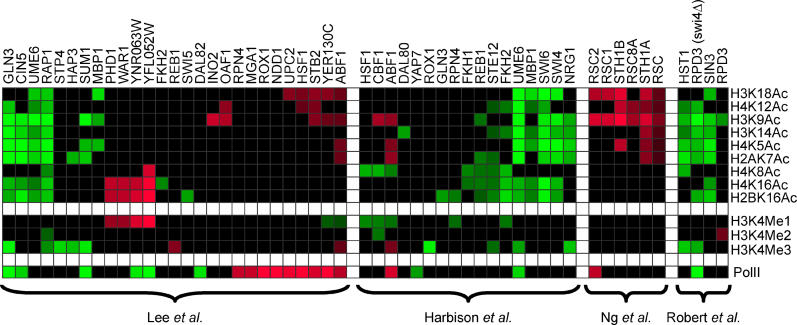
Histone ModifiersAnalysis of differential modification of nucleosomes associated with various transcriptional regulators. Promoter nucleosomes located near binding sites of the indicated factors were tested for enrichment of all modifications relative to the overall promoter modification pattern. Each cell is coloured by the average modification level of nucleosomes with this annotation. Non-significant cells (using false discovery rate of 95% on t-test p-values) are blackened. Localization data are taken from the indicated studies [39–42].